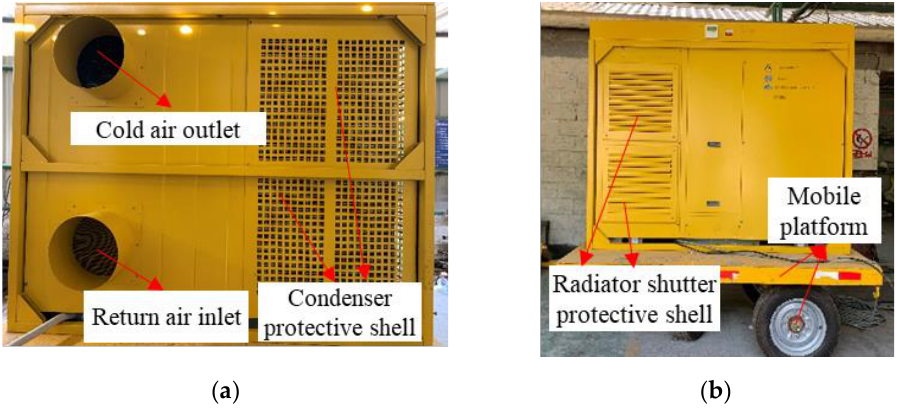
Figure 1. Appearance of refrigeration equipment: ( a ) front view; ( b ) rear view.